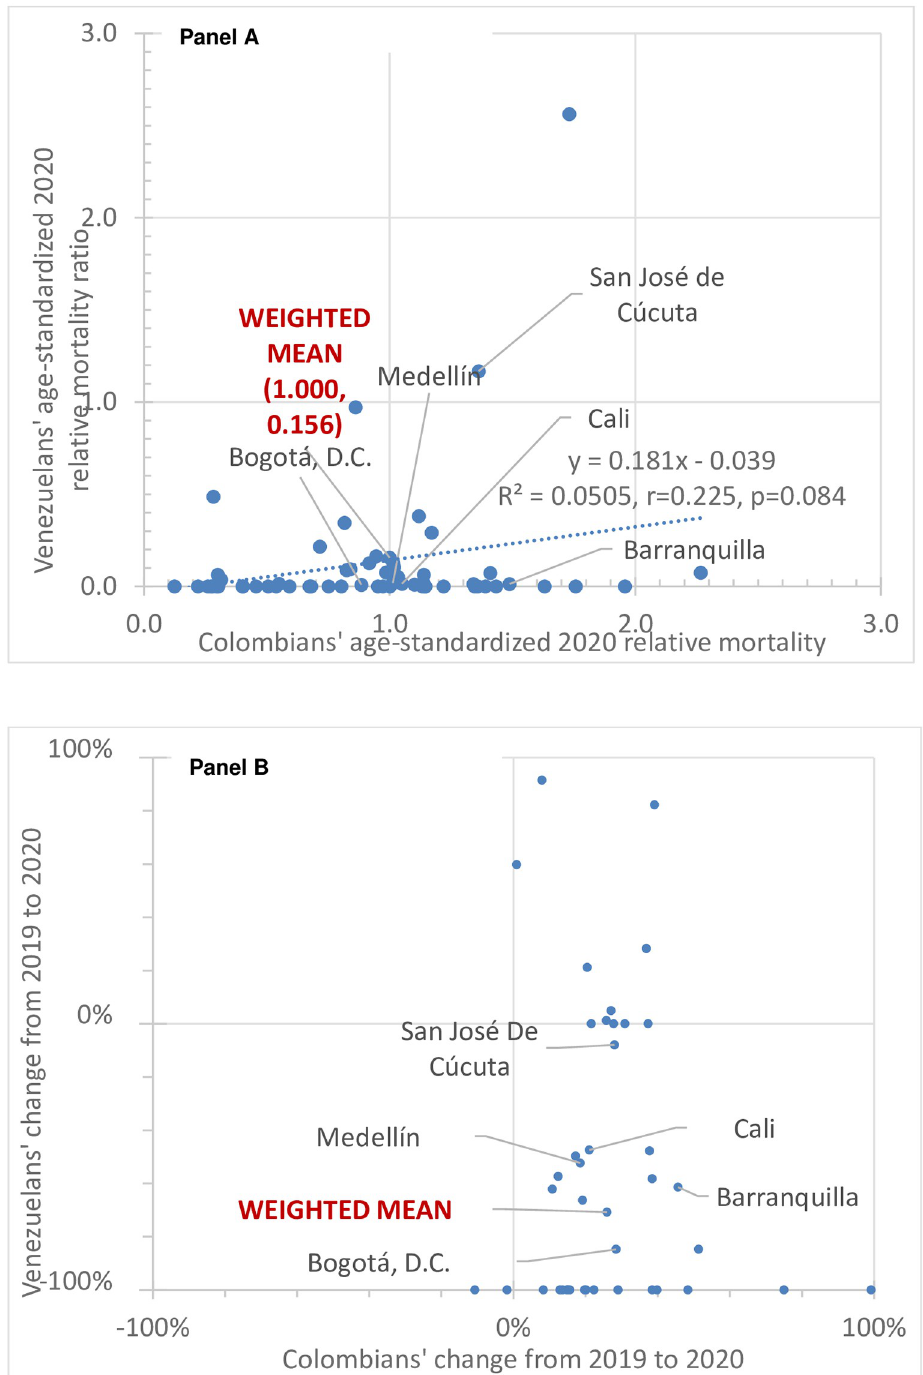
Fig 3. Adjusted age- standardized relative mortality by municipality and nationality showing (A) levels in 2020 and (B) percentage change from 2019 to 2020.